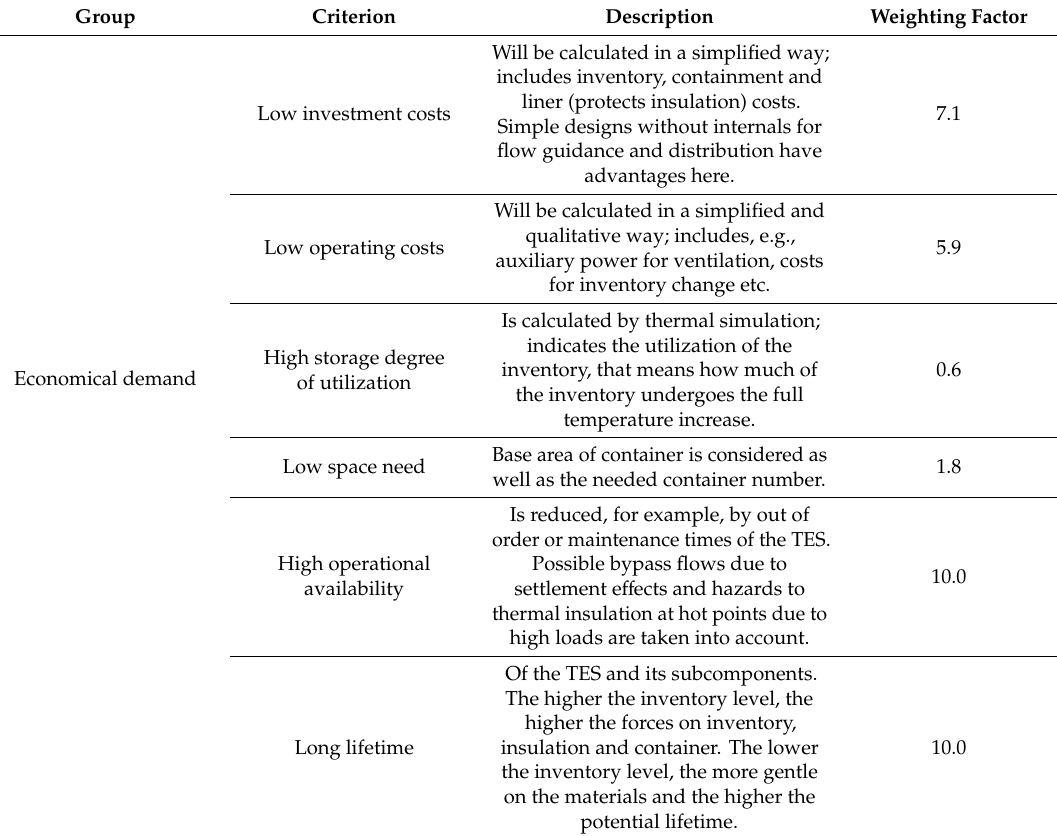
Table 4. Criteria for aptitude analysis.